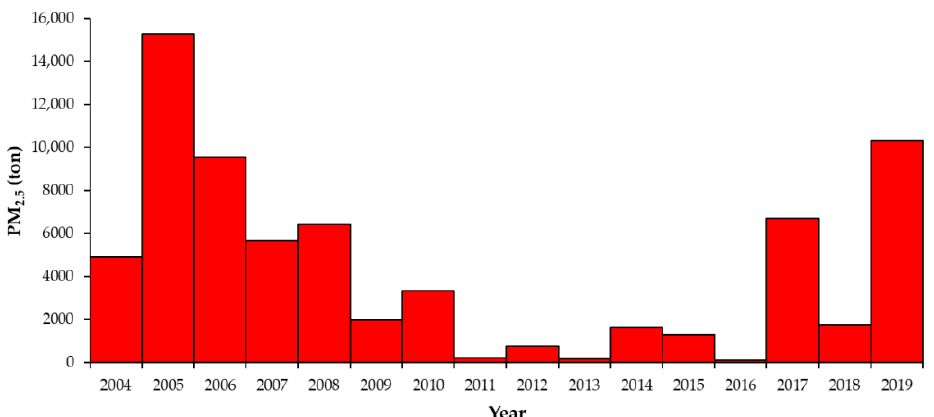
Figure 4. Annual total estimated emission of particulate matter (PM) 2.5 associated with fires in the Apyterewa Indigenous Land during the 2004–2019 period. Estimates were obtained using the Brazilian biomass burning emission model with fire radiative power (3BEM_FRP) model implemented in the PREP-CHEM-SRC emissions preprocessing tool version 1.8.3 [54].